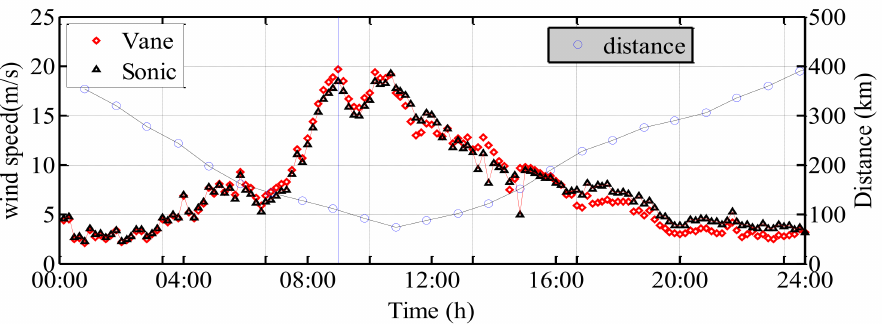
Figure 8. Comparison of the 10 min wind speed from a vane anemometer and a sonic